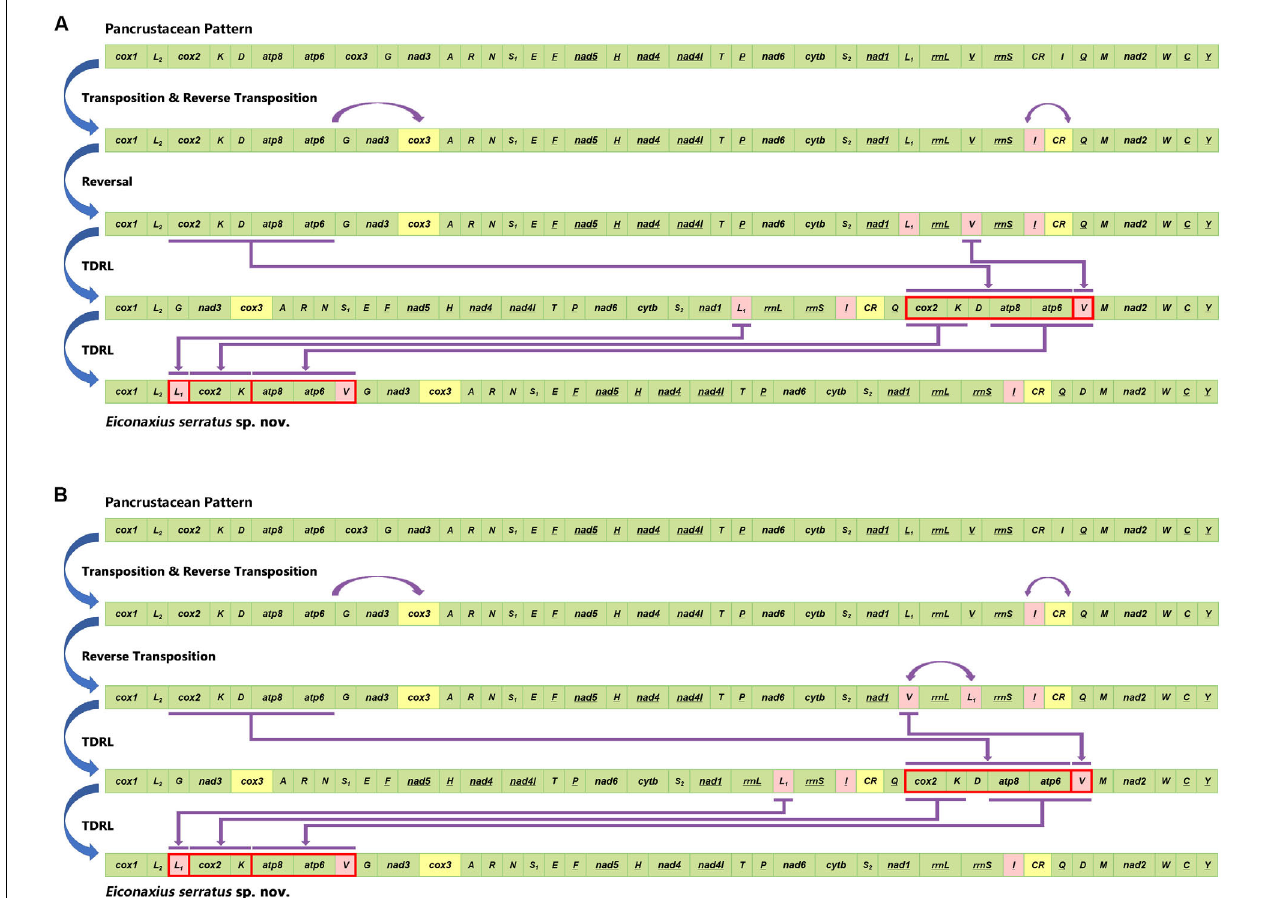
FIGURE 10 | Two alternative rearrangement scenarios (A,B) inferred from the putative ancestral state of the pancrustacean ground pattern to Eiconaxius serratus sp. nov. by CREx